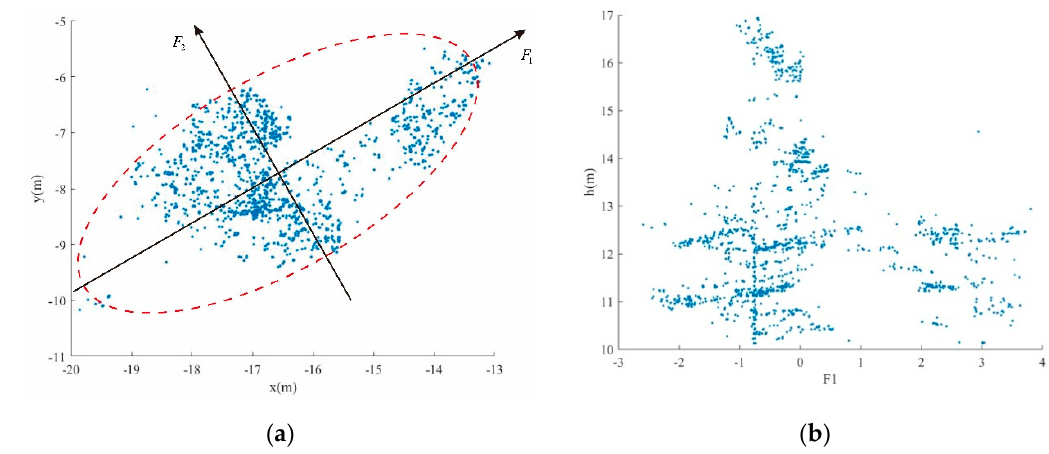
Figure 4. Canopy points projection transformation based on PCA principle. ( a ) Canopy points distribution in x and y directions; ( b ) the projection of points in the direction of the long axis of the ellipse.